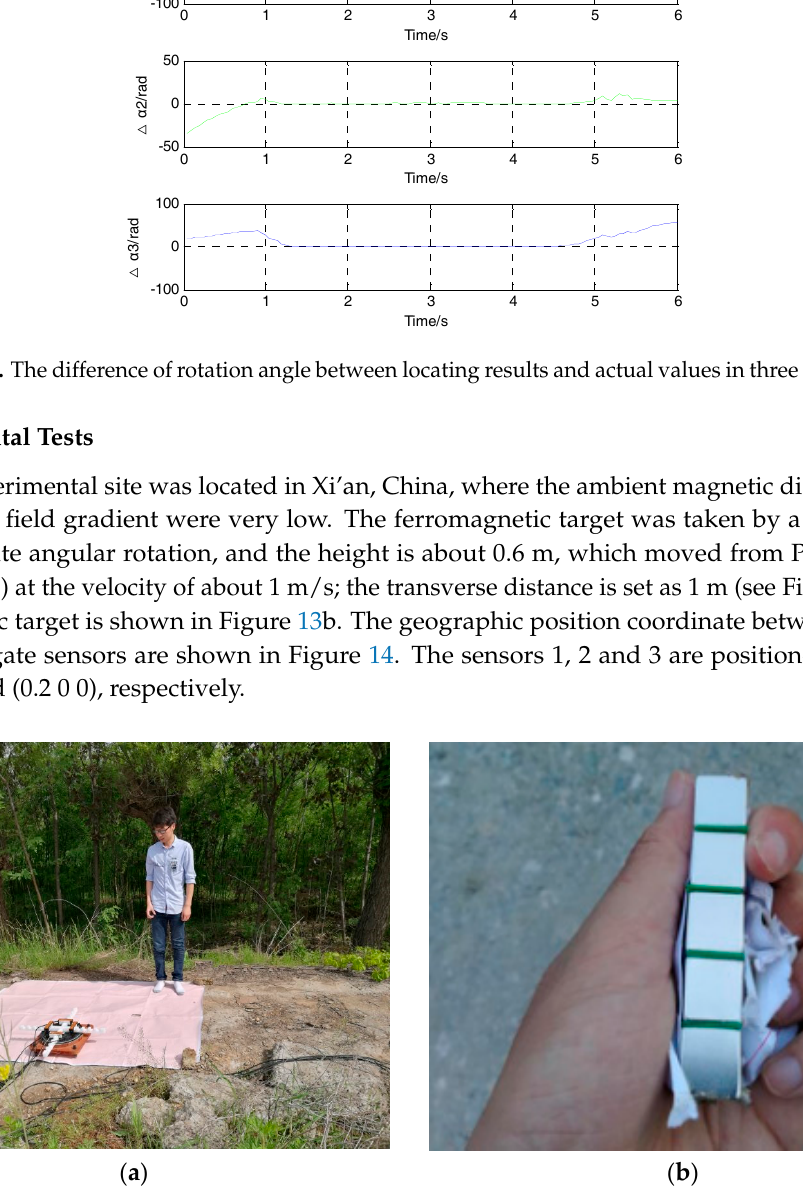
Figure 13. ( a ) The picture of experimental tests; ( b ) The ferromagnetic target taken by a experimenter.